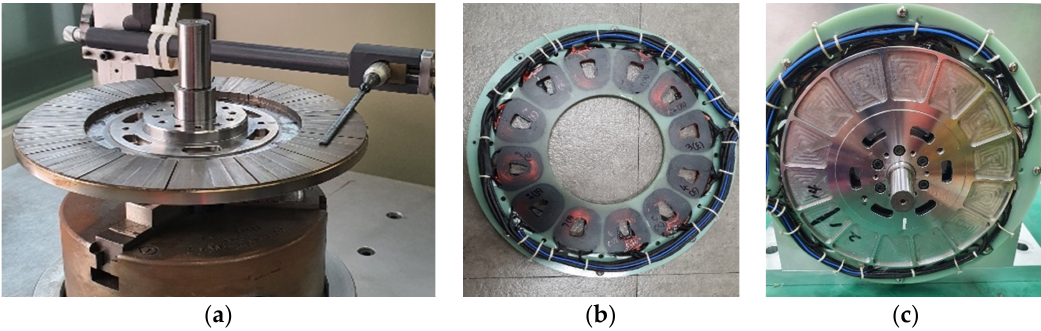
Figure 11. Fabricated ( a ) rotor; ( b ) stator; and ( c ) rotor–stator assay.